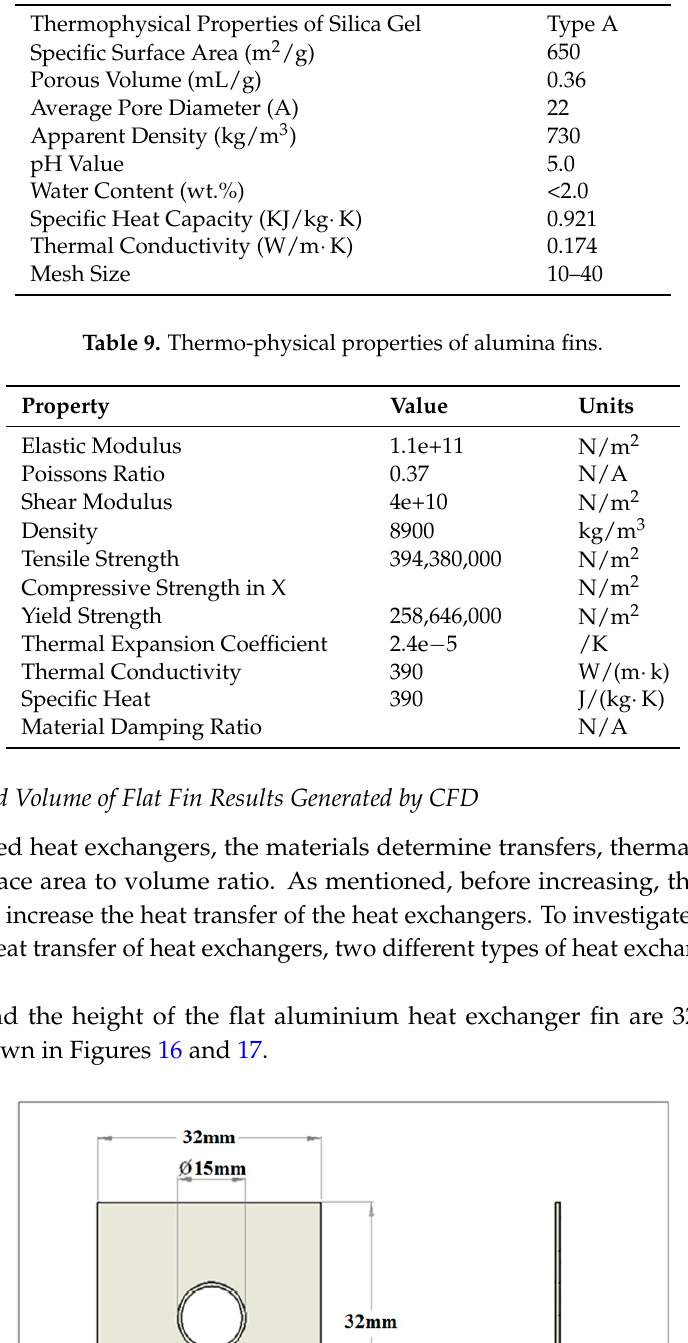
Table 8. Thermo-physical properties of silica gel.